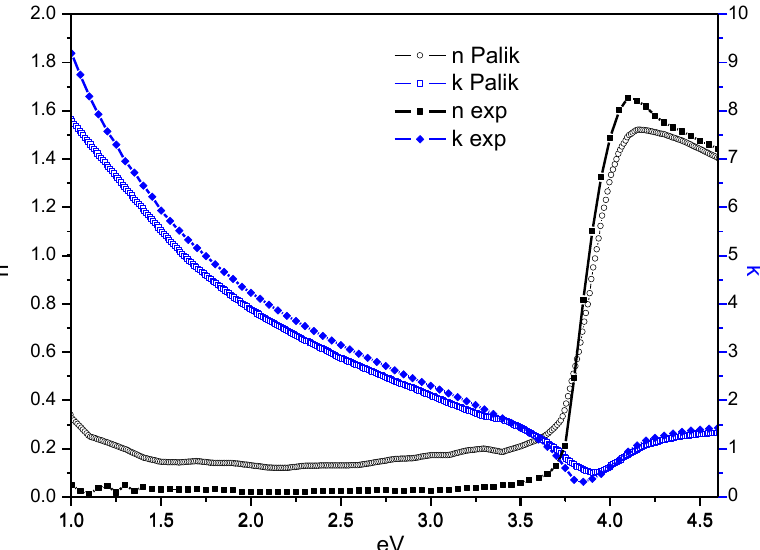
Figure 1. Comparison between the experimentally measured complex refractive index of silver layers and data taken from Palik’s book [21].